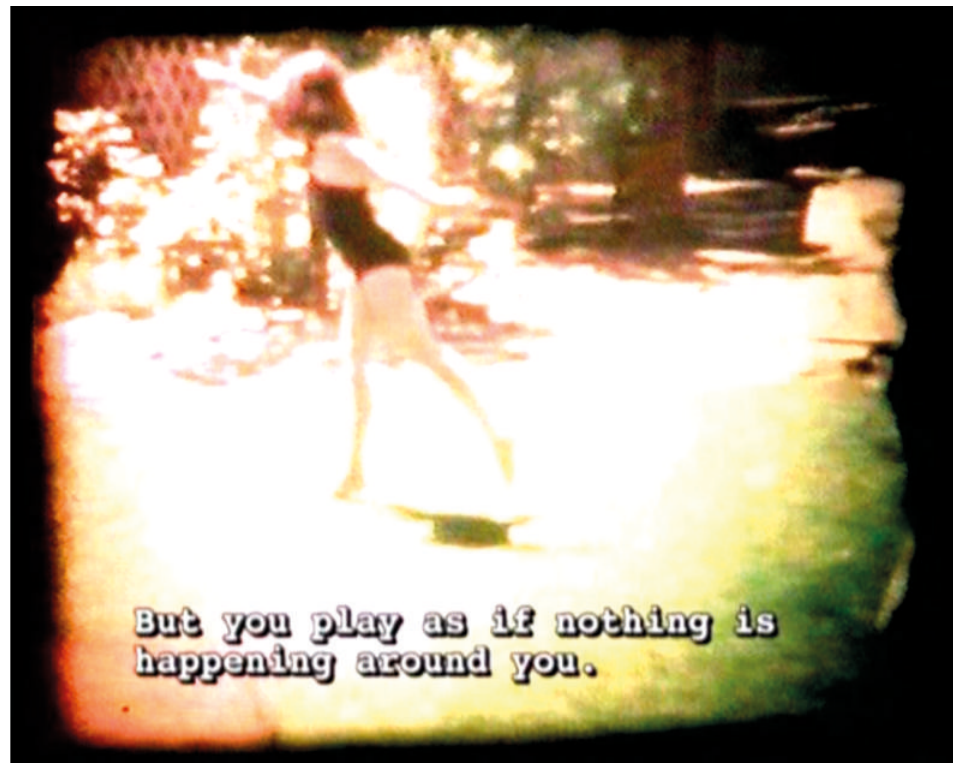
Figure 9 Penny Siopis, My Lovely Day (film still), 3 rd ed., 1997. Video installation of mini cinema and 8mm film transferred to video, 21 minutes. Museum of Modern Art, Stockholm; South African National Gallery, Cape Town; the artist (photo: courtesy Penny Siopis and Stevenson Gallery, Cape Town).